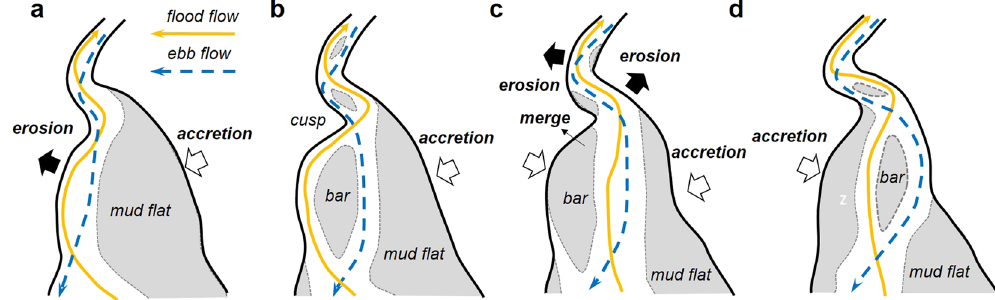
Figure 5. Channel-migration subprocesses. Lateral migration of tidal channel proceeds through meeting/ parting of flood and ebb channels, which are evasive with each other. ( a ) Flood and ebb flows form dominant channel on alternate sides, and rapid bank erosion occurs during this phase. ( b ) Channel meanders during bank erosion. Ebb flows no longer follow it from opposite side and thus create new, separate channel. ( c ) Flood flows shift to new channel as ebb flows deepen it. Channel along bank is filled out without active ebb flows. ( d ) Flood and ebb flows separate from each other as meander channel migration proceeds. Subsequently, flood flows shift to ebb channel to form dominant channel along other side of central basin. Illustrations were created using Microsoft Powerpoint 2016.